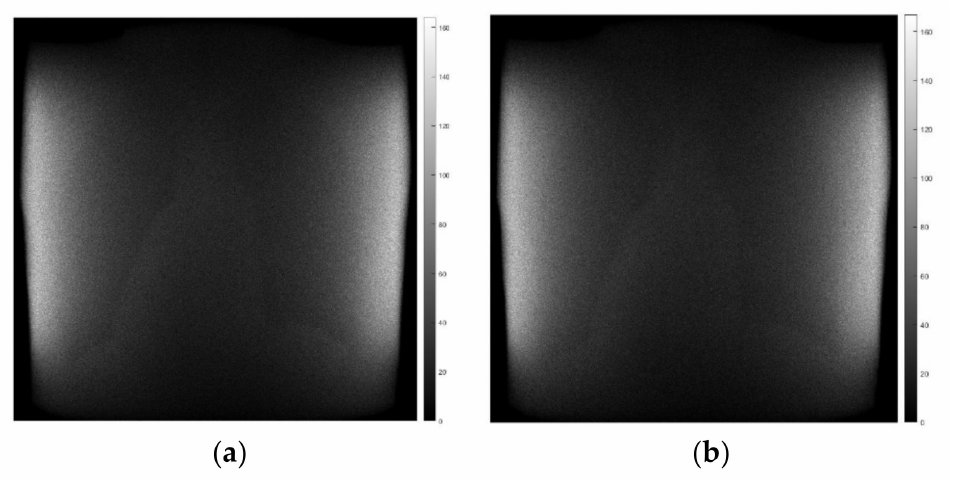
Figure 10. Fluorescence images of adjacent energy windows for 5 mg/mL of Au. 68.9–69 keV: ( a ); 69.1–69.2 keV: ( b ).